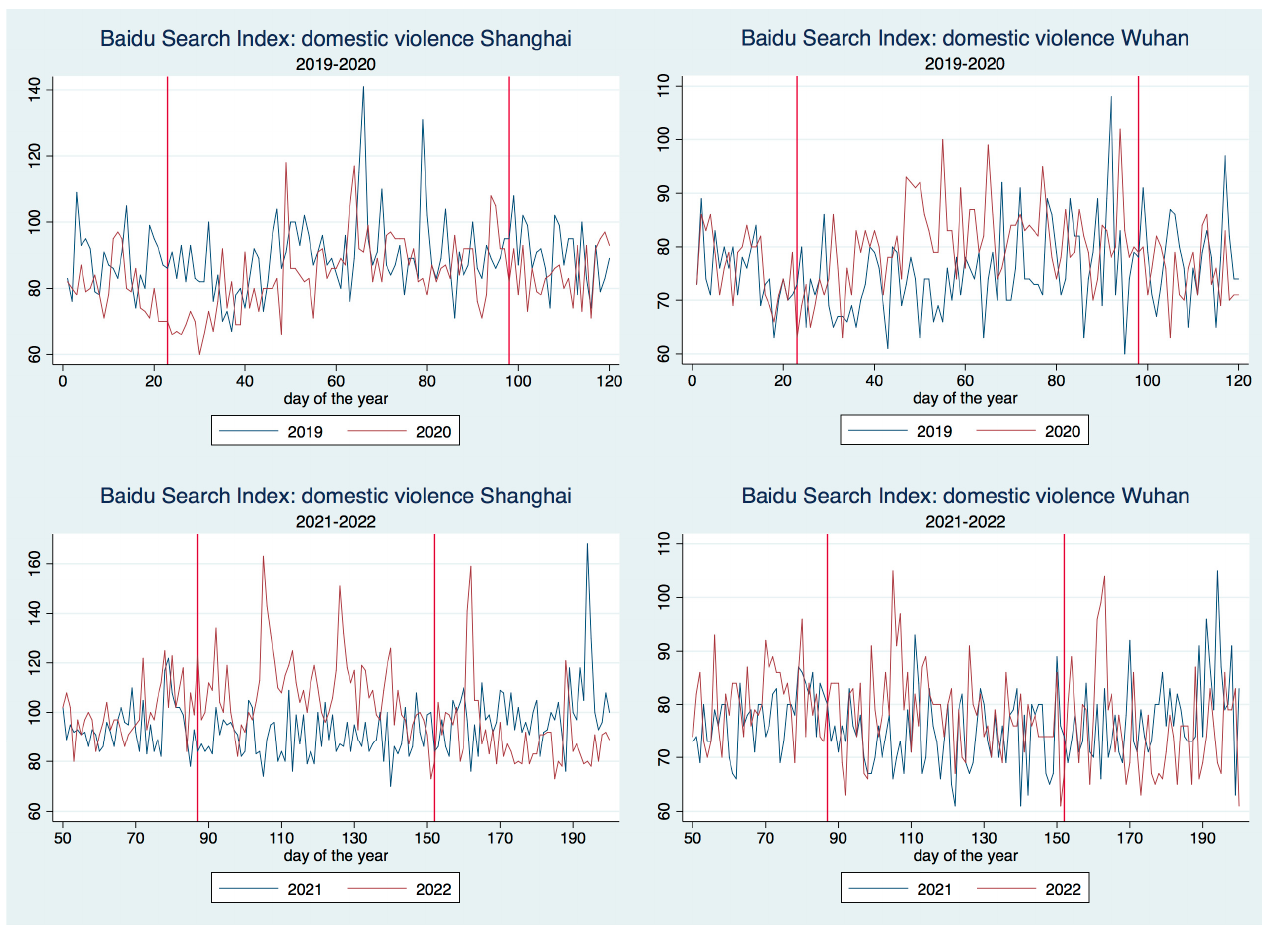
Figure 1. BSI trend for domestic-violence-related topic, Shanghai vs. Wuhan, 2019–2022.